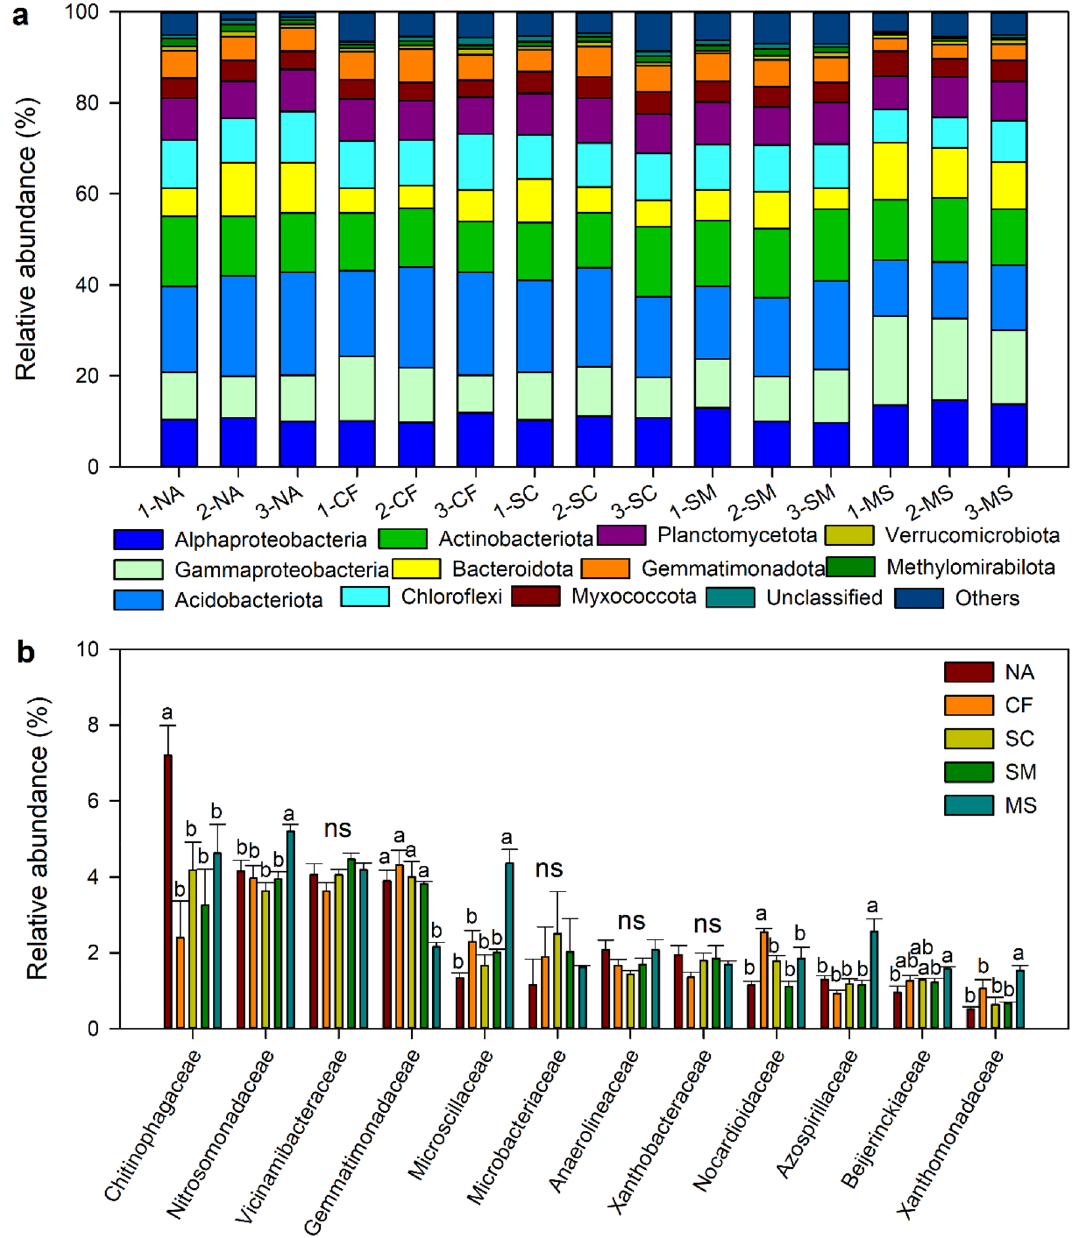
Figure 3. Changes in bacterial community at phylum level ( a ). The numbers before the treatment name indicate the sampling replications. ( b ) The bacterial community at family level. Different letters indicate significant difference at p < 0.05. ns represent no significant differences among treatments. NA, no fertilizer; CF, inorganic fertilizer; SC, inorganic fertilizer plus organic fertilizer; SM, organic fertilizer; MS, maize